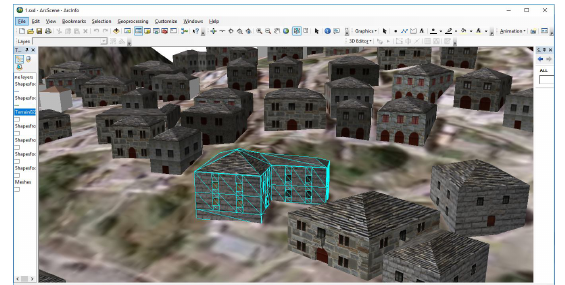
Figure 12. Selection of a building for analysis, ArcScene.